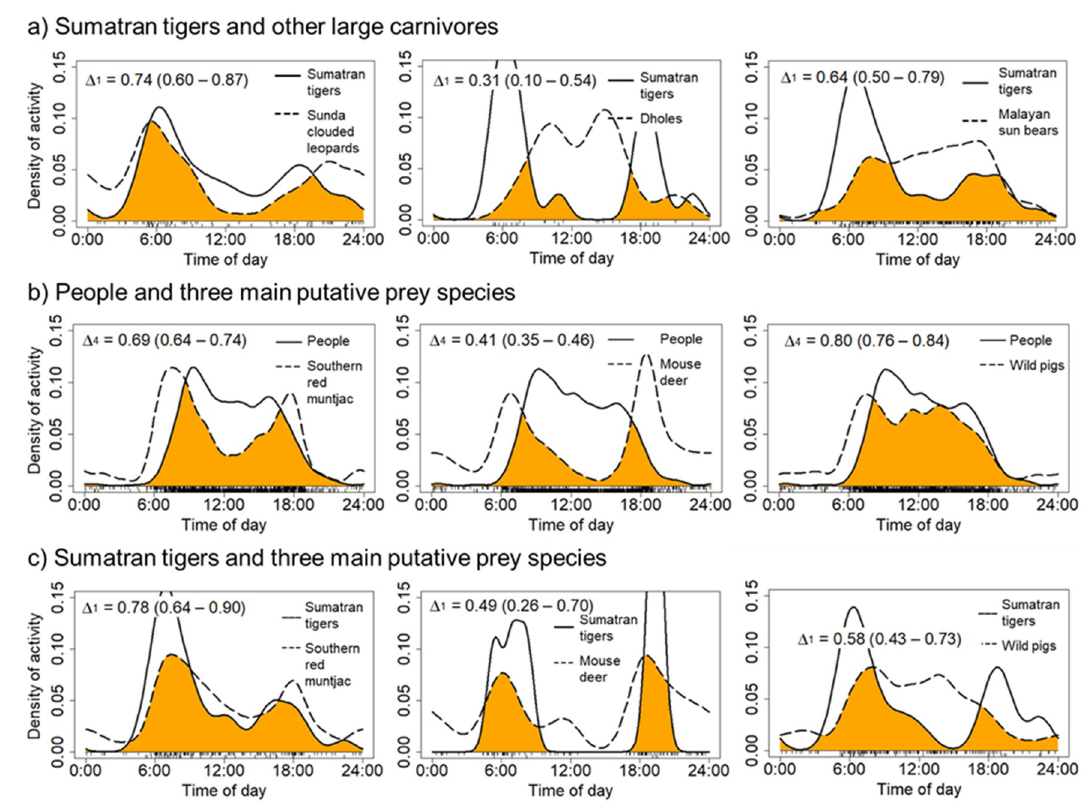
Fig 9. Estimates of the daily activity patterns of people, Sumatran tigers, three other large carnivores, and three main potential prey species. The overlap coefficient is indicated by the shaded orange area in each plot with the estimate of overlap ( Δ ) and 95% CI.